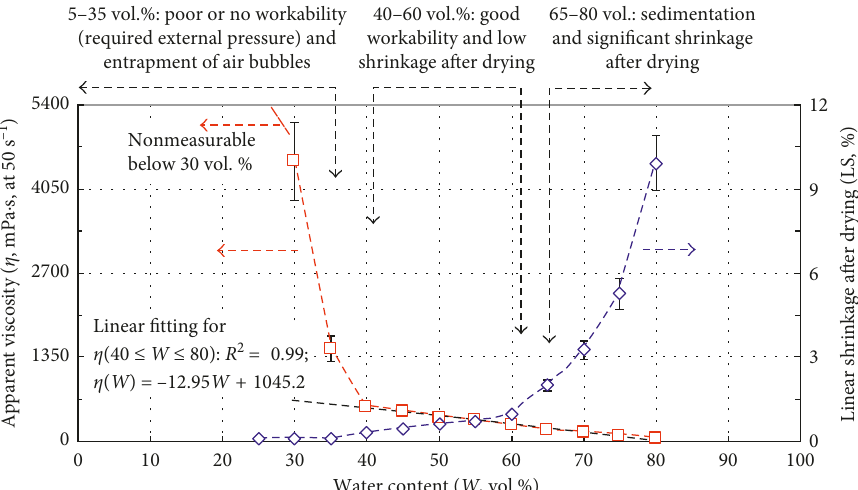
Figure 6: Effects of water content ( W vol.%) on compositions’ apparent viscosity ( η , mPa · s − 1 , measured at 50 s − 1 and 25 ° C) and linear shrinkage after drying (LS, %, after 24h at 120 ° C, for samples cured in the conventional static way).